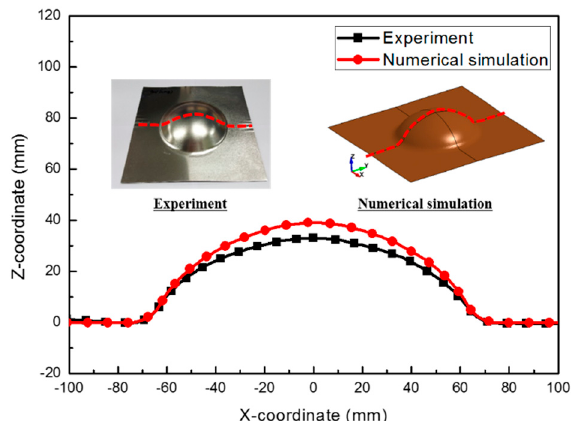
Figure 9. Comparison of numerical simulation and experiments.